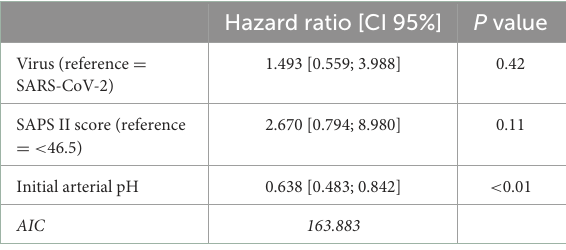
TABLE 5 Predictive factors of mortality (multivariate Cox model) – SAPS II score